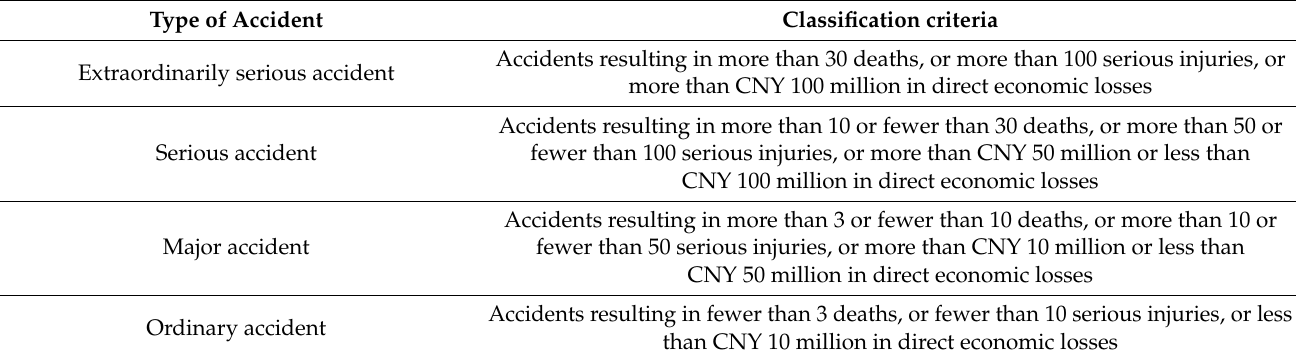
Table 1. Accident type classification standards.